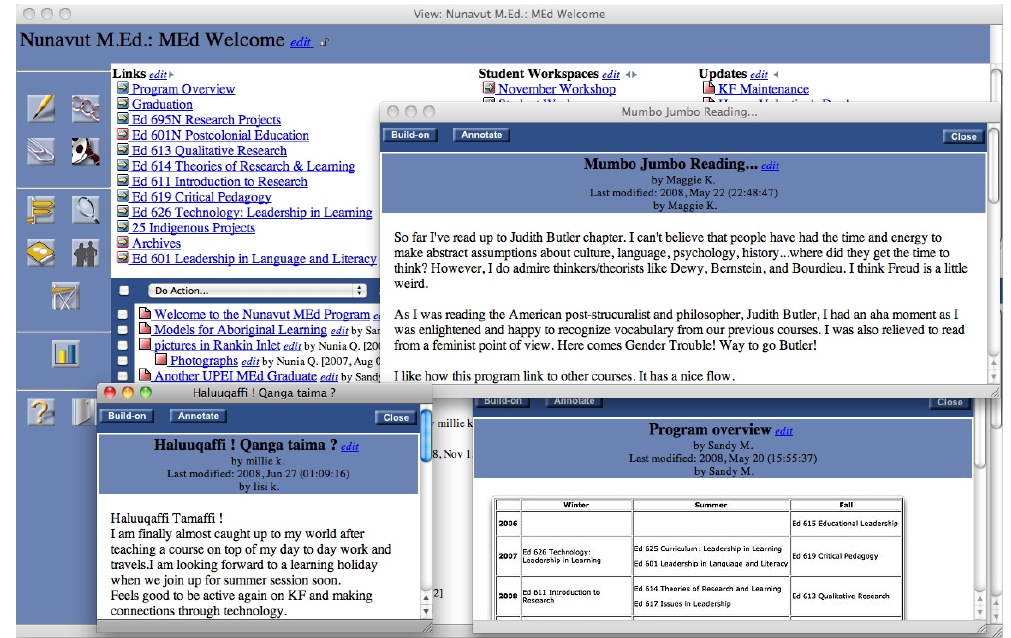
Figure 3 . An illustration of some of the features of the